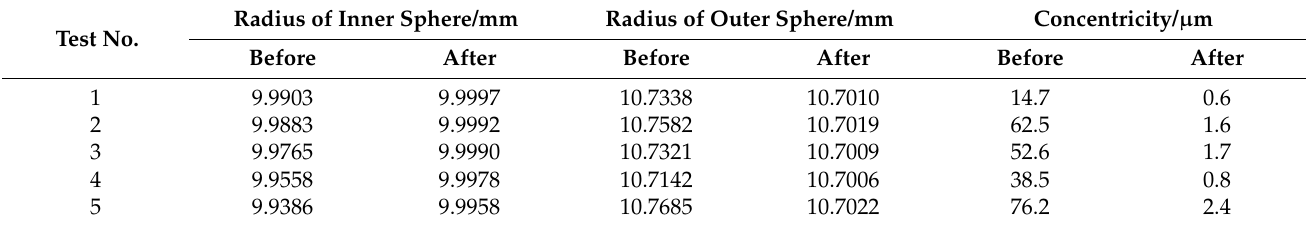
Table 2. Results before and after compensation of radius and concentricity